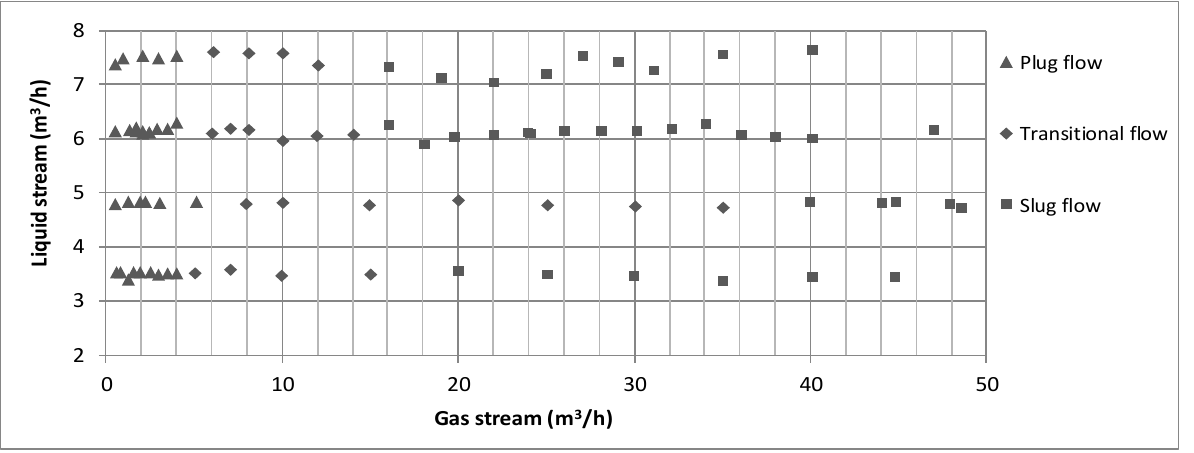
Figure 3. The decomposition types of the test flows’ series are determined within the whole measurement range.